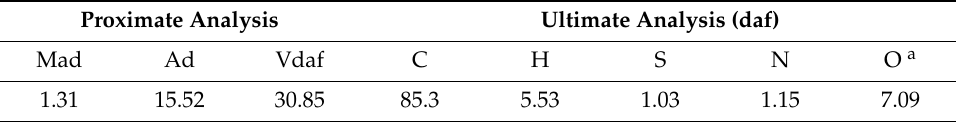
Table 1. Proximate and ultimate analyses of Daxing coal (wt.%). Proximate